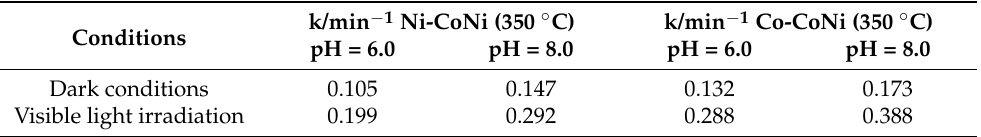
Figure 6. Catalytic degradation of TCs as a function of the light irradiation of Ni–CoNi and Co–CoNi deposits thermal treated during 2 h at 350 ◦ C at ( a ) pH 6.0 and ( b ) pH 8.0. Experimental conditions: 20 ppm of TCs, [PMS] 0 = 0.3 mM, T = 20 ◦ C, and in dark conditions or under visible light irradiation (i.e., 5 mW cm − 2 ). Table 4. Kinetic constants of the degradation of TCs in dark conditions and under visible light irradiation (i.e., 5 mW cm − 2